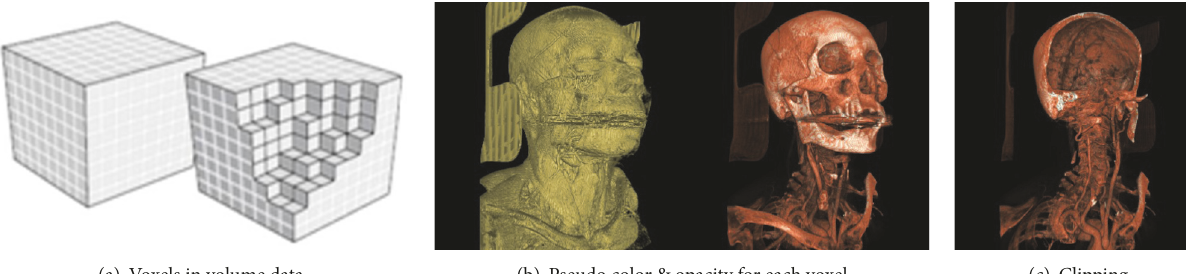
Figure 2: Schematic diagram of the direct volume rendering method.